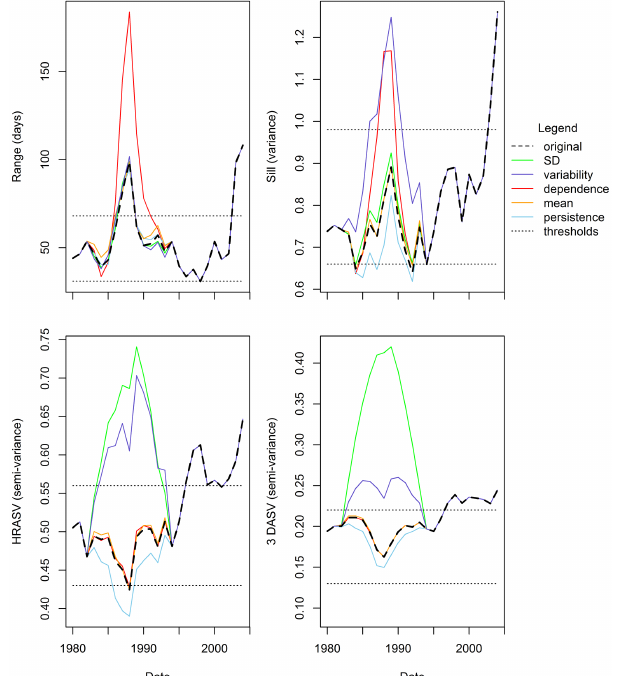
Figure 5. Relationship between the variogram parameters when cal- culated using all the available data and the parameters using 90% of the data. The red lines show the spread of acceptable values. Any catchments with points outside the red lines were